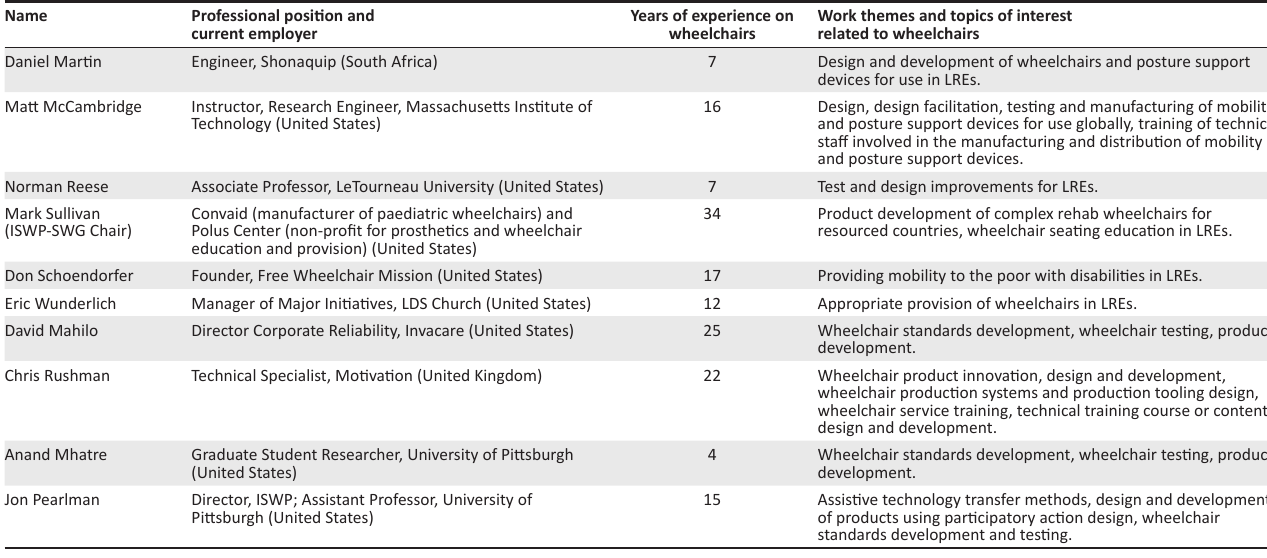
FIGURE 5: Wheelchair models designed for less-resourced environment TABLE 3: International Society of Wheelchair Professionals Standards Working Group member profiles.